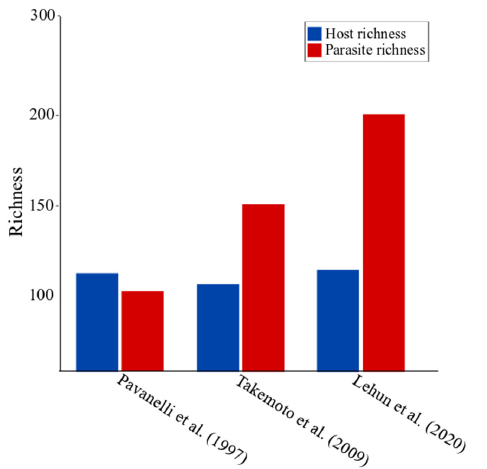
Figure 3. Richness of parasites and hosts in the upper Paraná River floodplain over the years based on the 3 record updating papers.